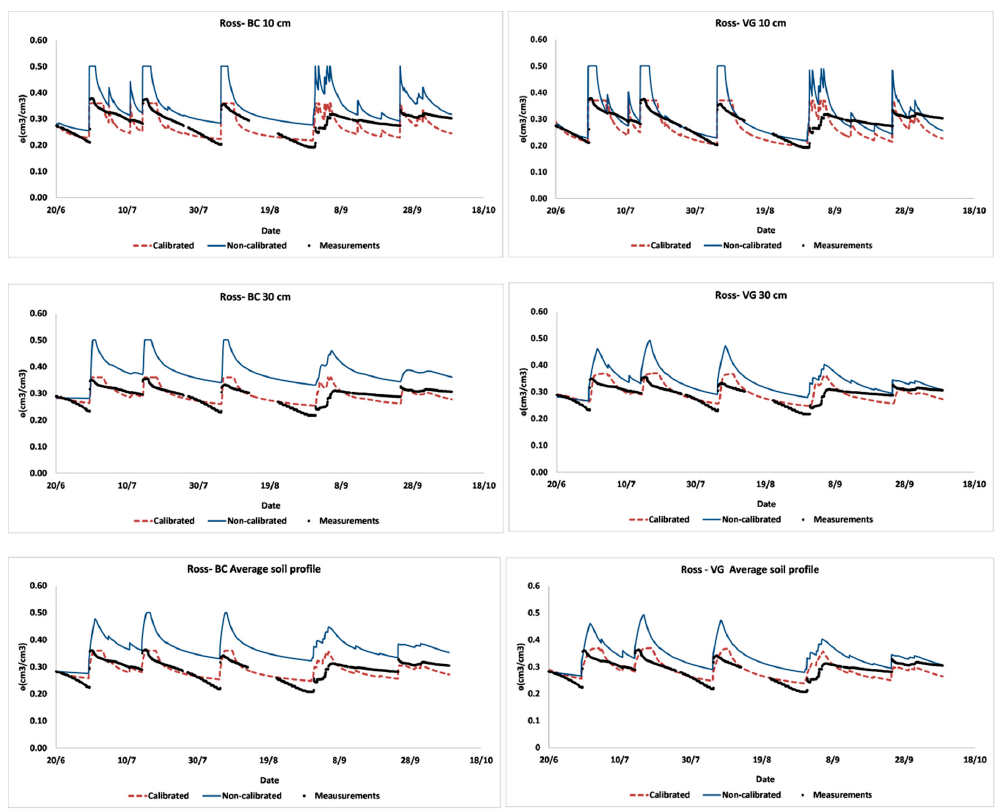
Figure 4. Results of calibration of Ross–Brooks and Corey and Ross–Van Genuchten.